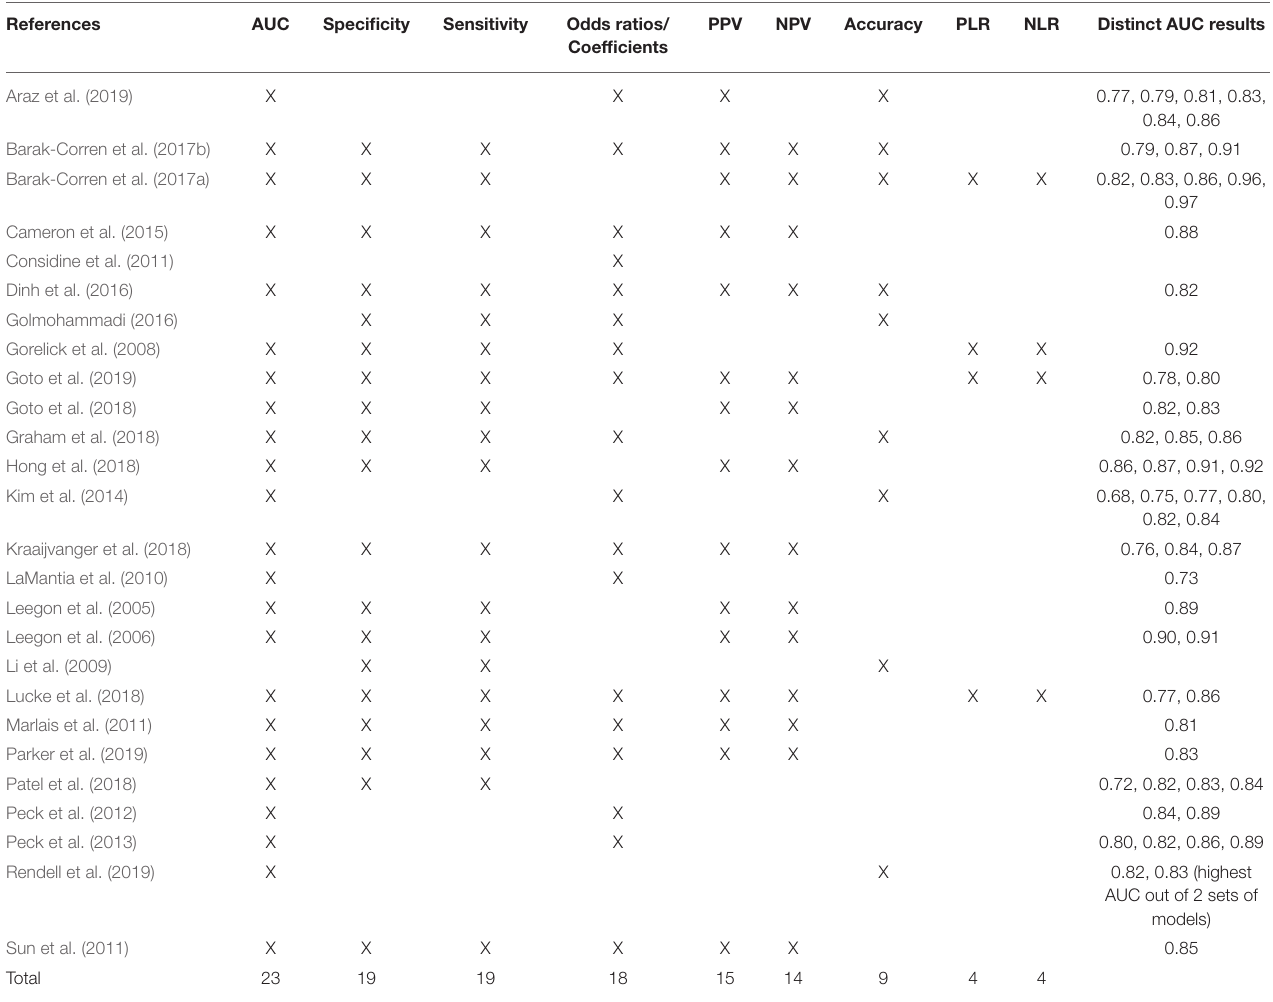
TABLE 2 | Most commonly used model evaluation methods and AUC results across the 26